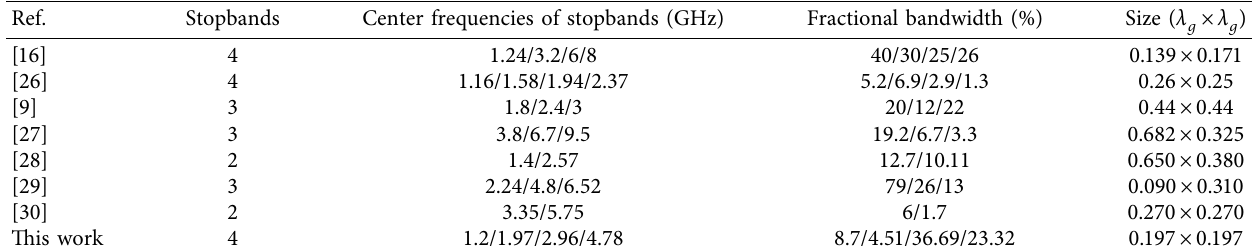
Table 3: Comparison between this work and other reported multiband bandstop filters.